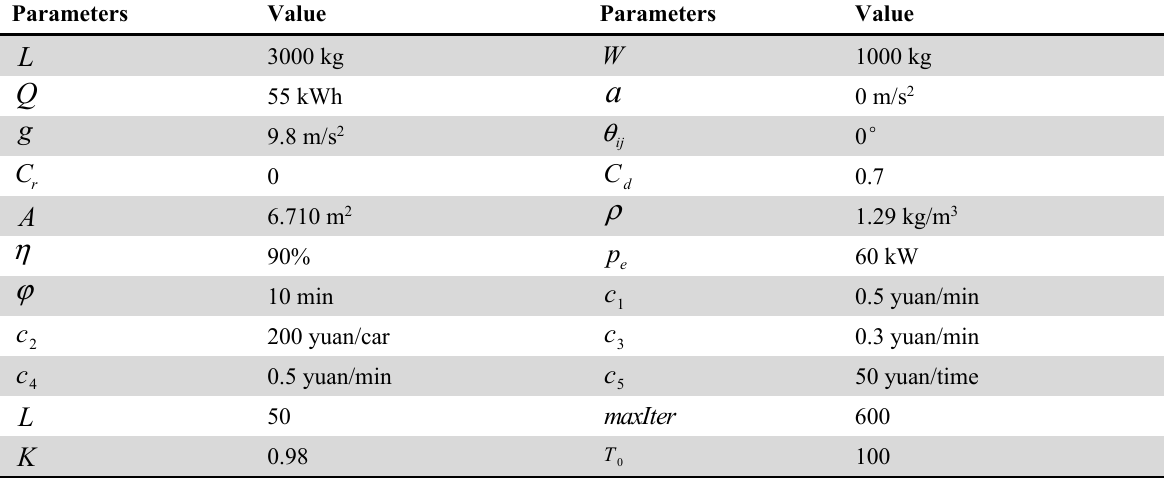
The settings of model variables and algorithm parameters